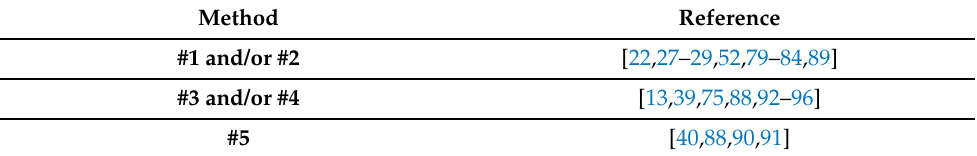
Table 1. Overview of research papers that use the examined methods to perform inertia estimation.